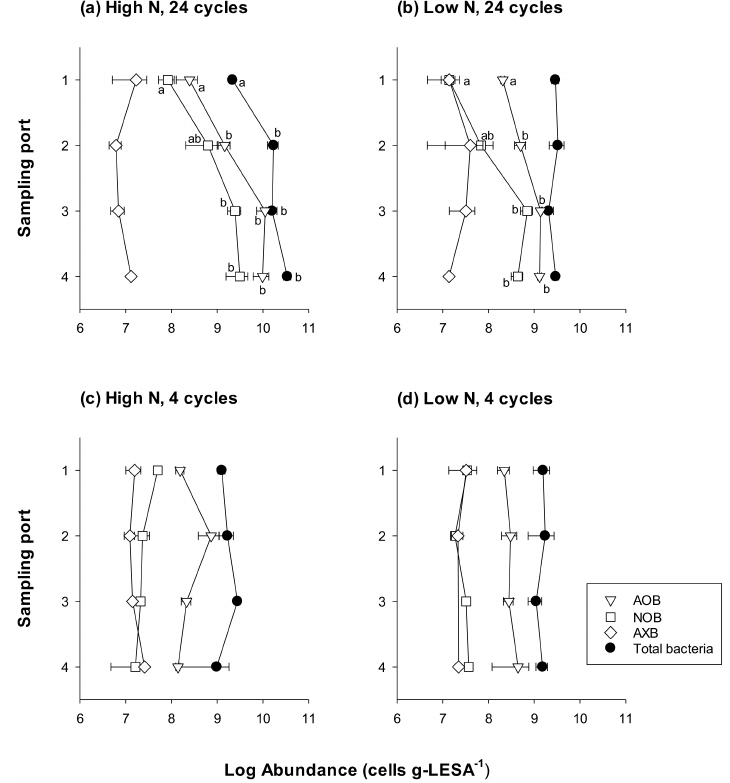
Figure 2. Representative graphs showing the vertical profiles of abundance for total bacteria, ammonium oxidizing bacteria (AOB), nitrite oxidizing bacteria (NOB), and anammox bacteria (AXB) in each reactor. The top row ( a , b ) presents data from the end of the 24 cycles day − 1 treatment, and the bottom row ( c , d ) is from the treatment with 4 cycles day − 1 . Points represent means with standard error bars (N = 3 replicate samples per reactor per sampling depth). Whenever ANOVA revealed an effect of depth (Table 1), Tukey’s post hoc tests were used for pairwise comparisons; within a given functional group, means with the same lower-case letter are not significantly different. Table 1. Results ( p -values) for ANOVA applied to compare the abundance of each microbial group across the sampling depths for the graphs presented in Figure 2. AOB: ammonium oxidizing